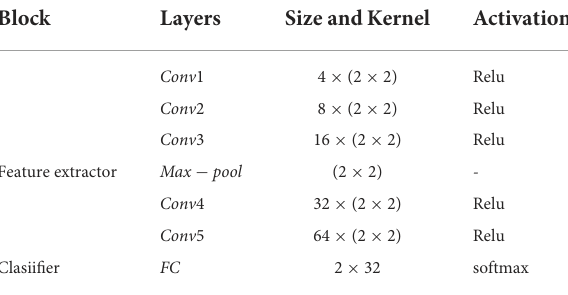
TABLE 3 Basic parameter of SPD-CNN model.